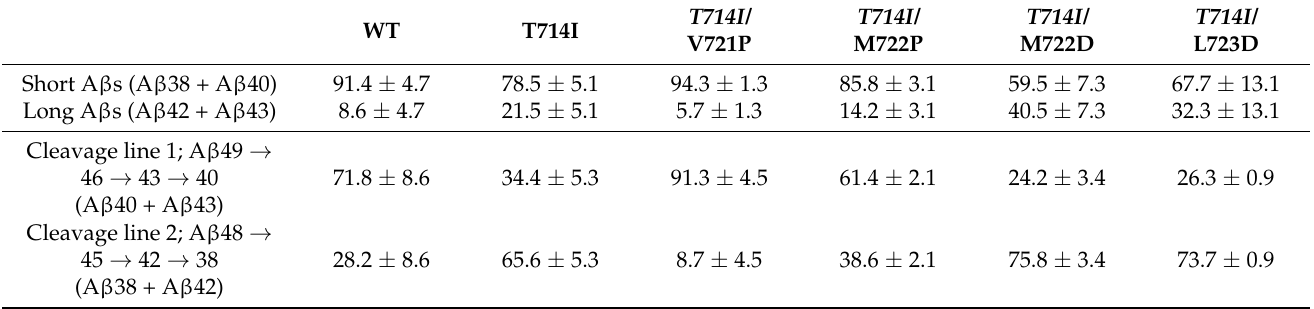
Table 3. Summary of the proportions of A β species produced by APP WT, T714I, and secondary mutants with T714I in CHO cells. Percentages are expressed as the average of three independent assays ± 95% confidence interval.